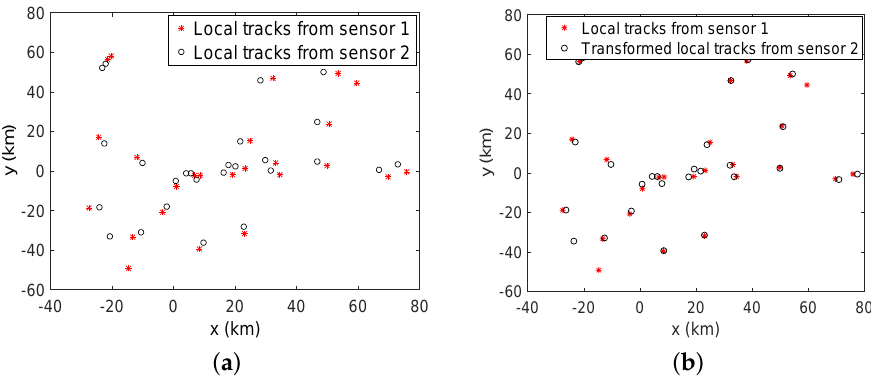
Figure 5. ( a ) Local tracks at time step k = 50 ( b ) Local tracks at time step k = 50 after transformation with proposed method.